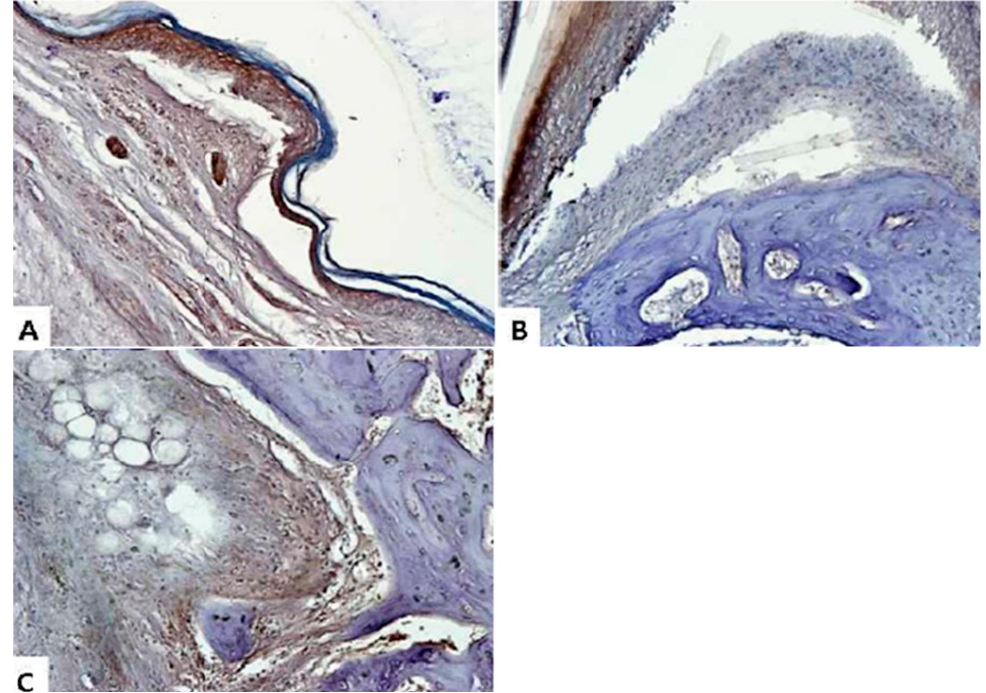
Figure 8. Immunohistochemical analysis of TNF- α from the CIA model knee joint. ( A ) CIA group; ( B ) 200 mg/kg of S. muticum extract; ( C ) positive control (Joins, 10 mg/kg). Images are magnified ×200.